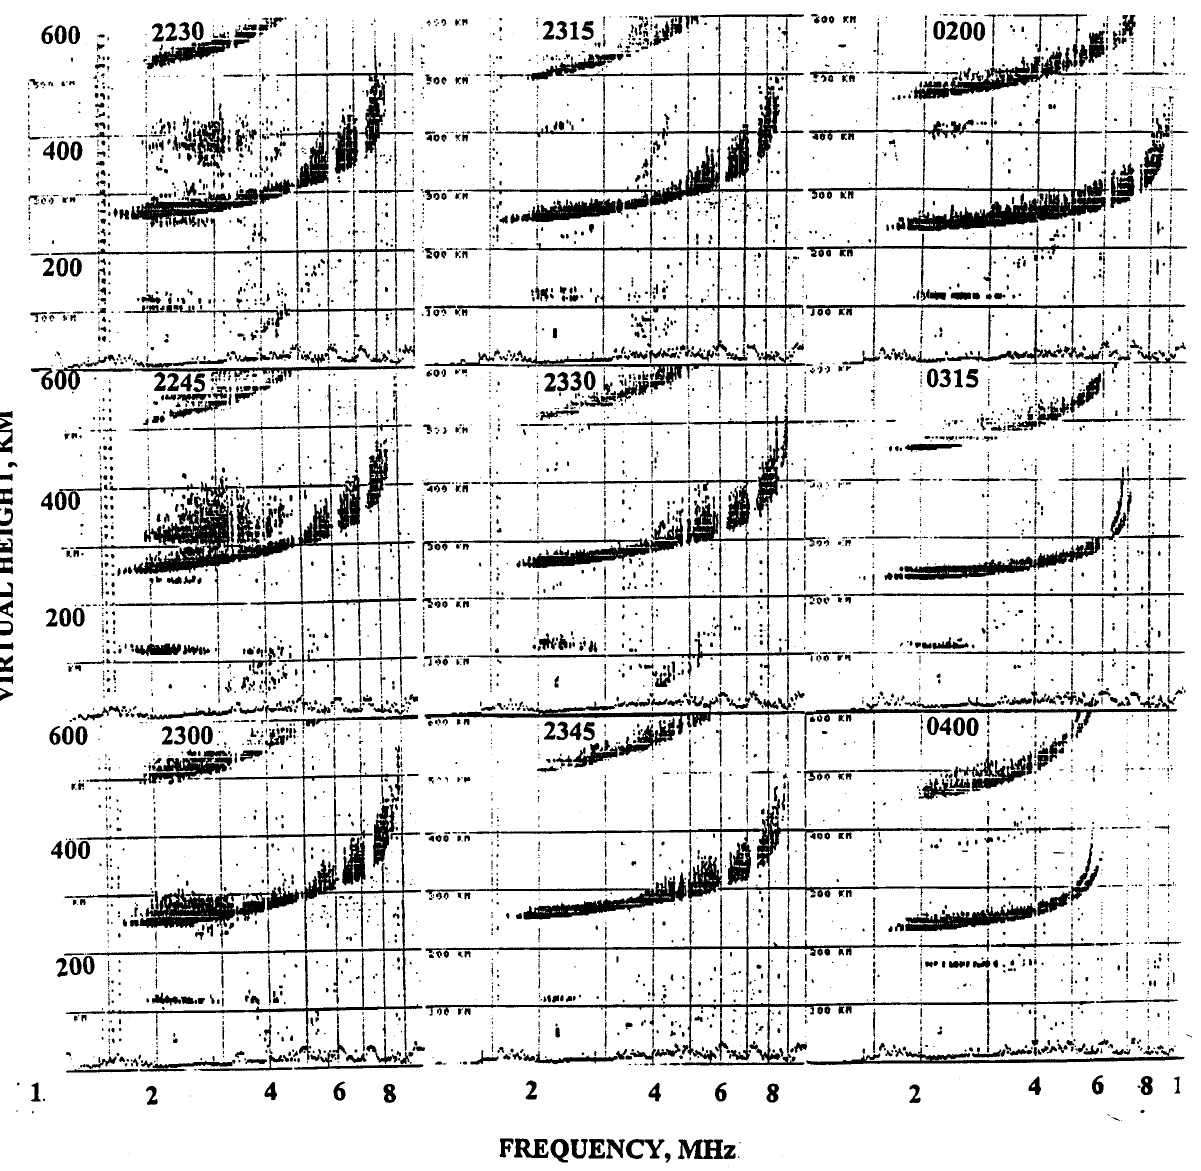
Fig. 9. Selected ionograms over Thumba during the night of 17–18 November 1998 showing the development of sporadic-E associated with Leonid shower